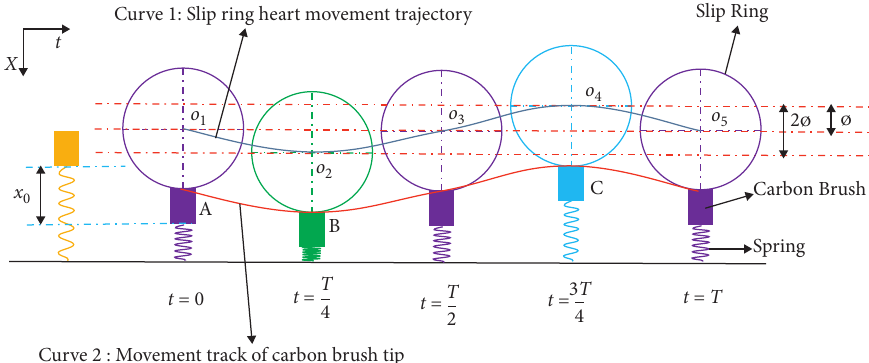
Curve 2 : Movement track of carbon brush tip Figure 3: Schematic diagram of spring compression in T /2 cycles.